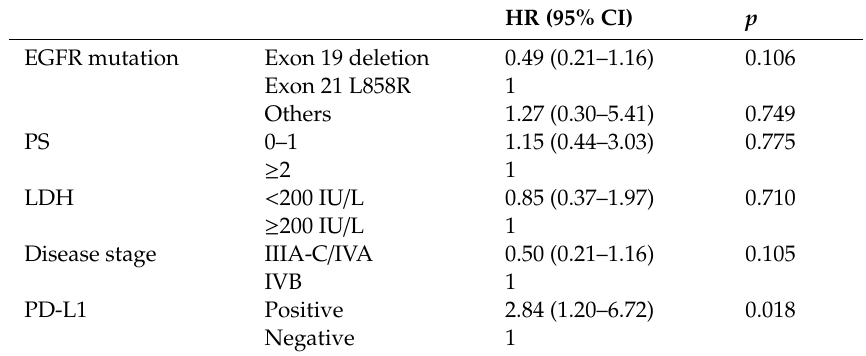
Table 3. Associations of the patient characteristics with the PFS (Cox proportional hazards